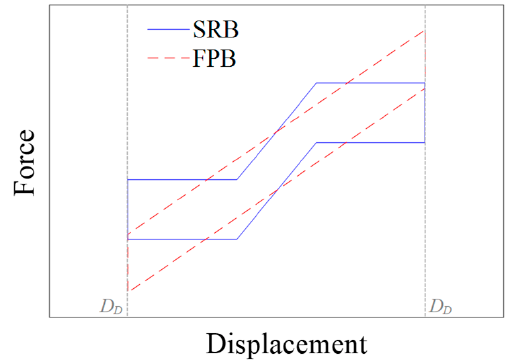
Figure 2. Typical hysteretic behavior of FPBs and SRBs.